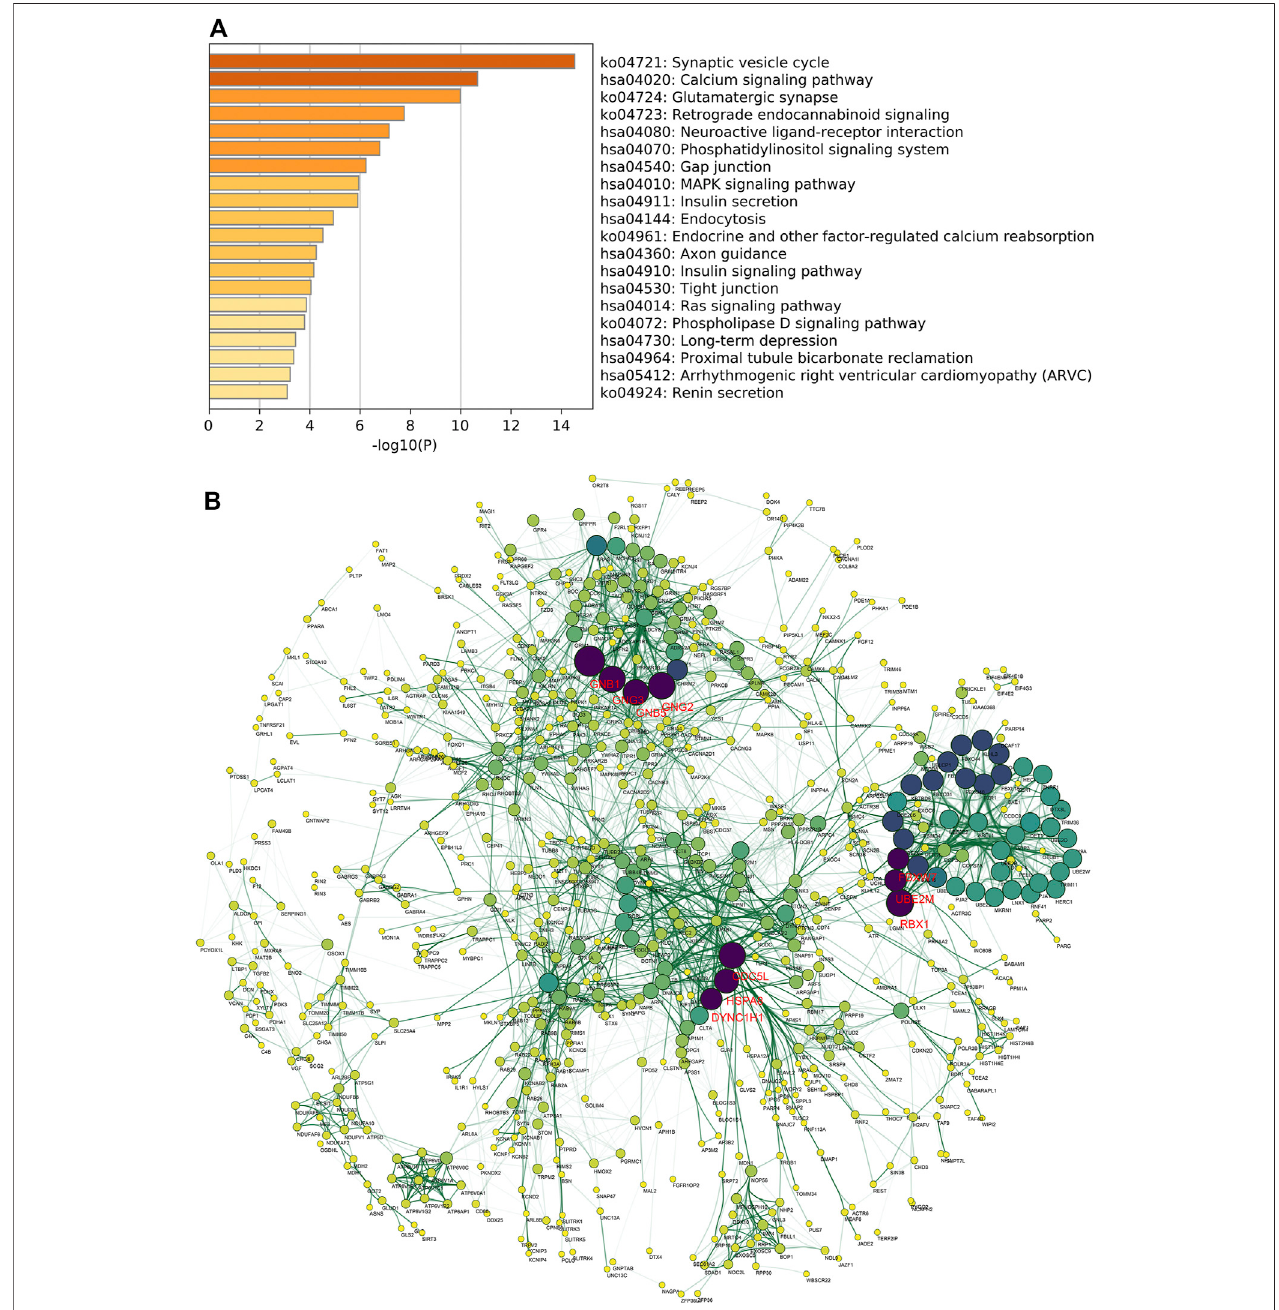
FIGURE 7 | TGFBR3-related genomic alterations. A total of 1824 TGFBR3-related genes were identi fi ed based on the screening criteria |r| > 0.6 and p < 0.05 from expression dataset 3. Then the KEGG pathway enrichment analysis was conducted by Metascape (A) Bar graph of the top 20 enriched KEGG pathways of TGFBR3- related genes, colored by p -values (B) The PPI network of TGFBR3-related genes was constructed by STRING v11.5 and visualized by Cytoscape v3.8.2. hub genes wereidenti fi edfromthenetworkaccordingtothedegreevalue.ThenthedegreescoreofeachgeneinnetworkwascalculatedbycytoHubbaandthe10geneswith the highest degree score were identi fi ed as hub